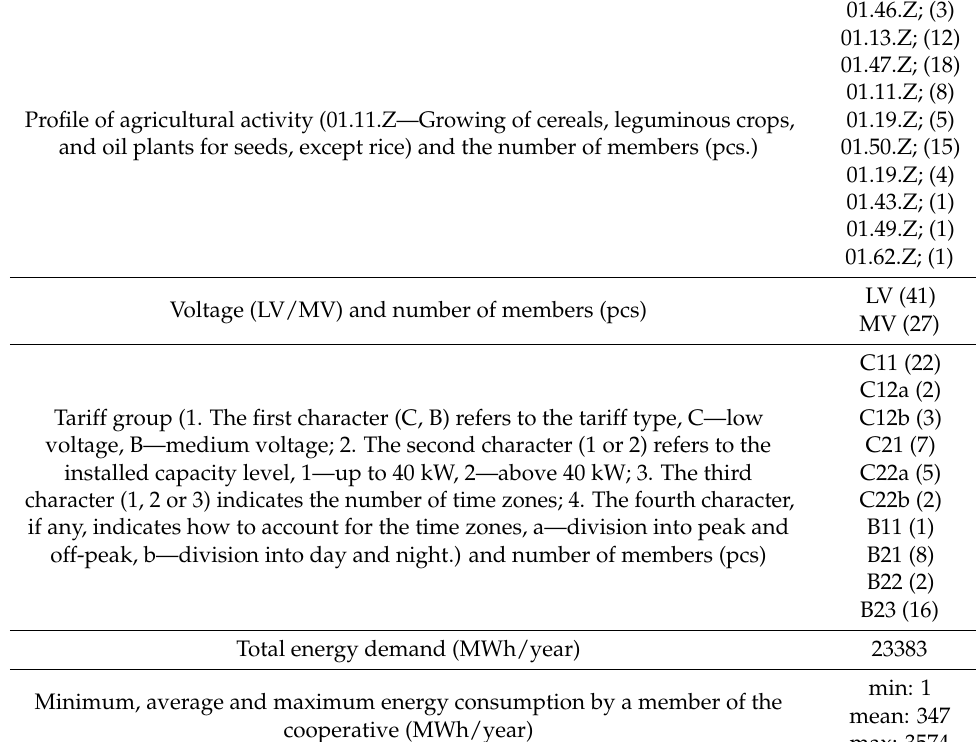
Table 1. List of selected parameters characterizing the demand side.